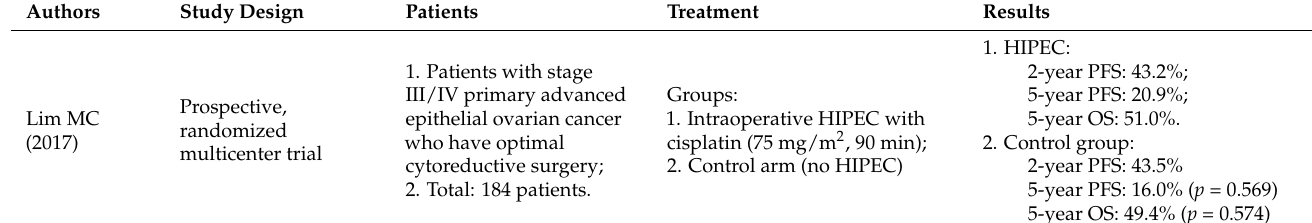
Table 2. A summary of clinical studies investigating HIPEC treatment for primary advanced ovarian